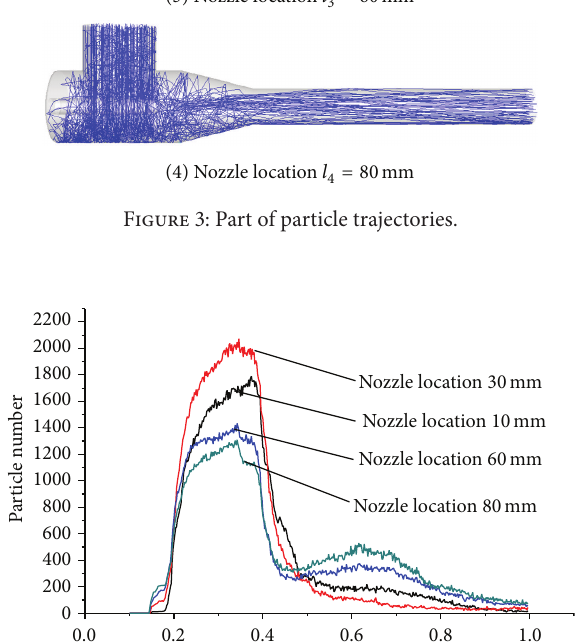
Figure 4: The number of extrusive particles in 0.2 s feeding time.